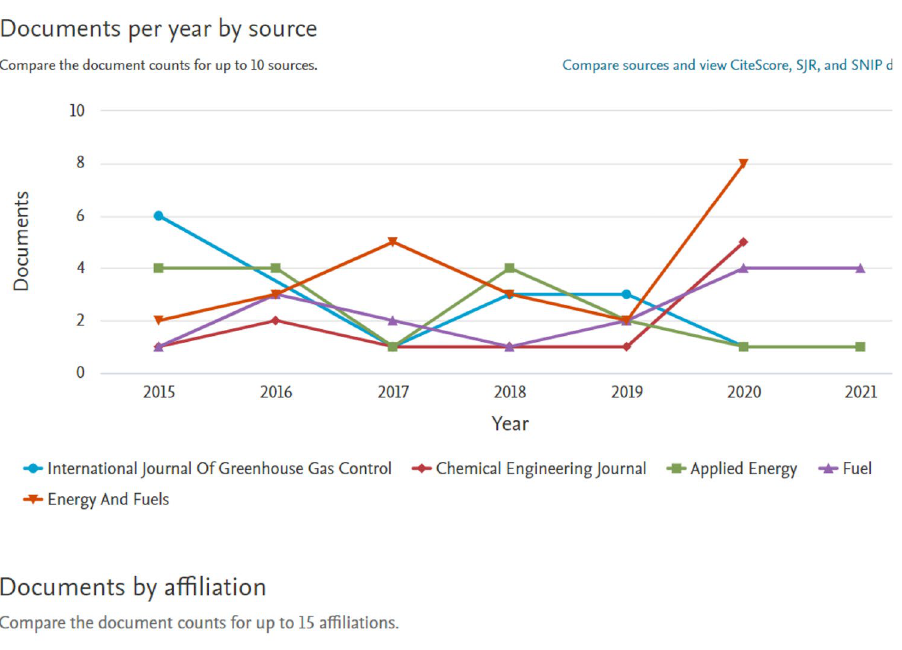
Fig. 6 Documents by Affili- ation (Source: www.